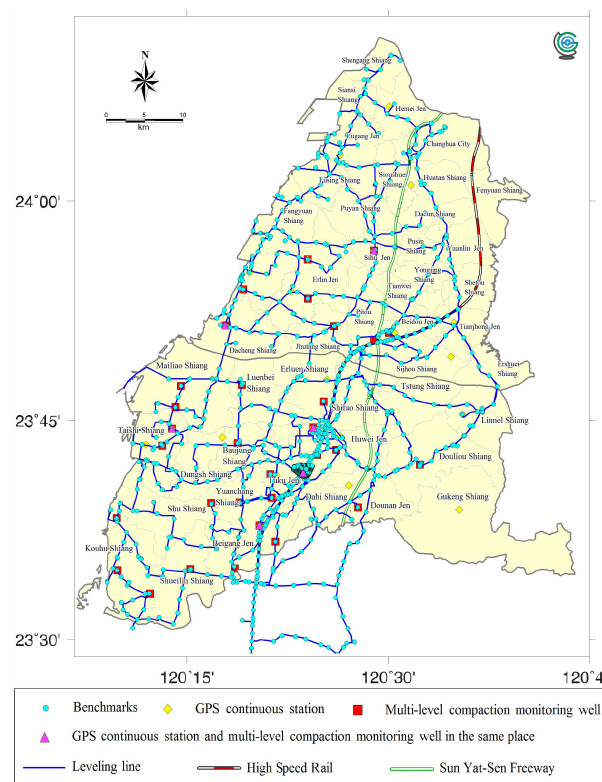
Figure 4. Distributions of leveling benchmarks, monitoring wells and CORS GPS stations in CRAF, the names of townships in Yunlin County and Changhua County are shown here.